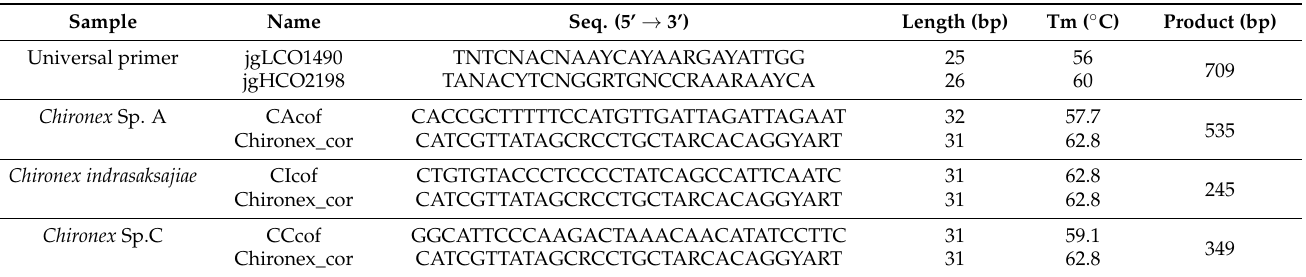
Table 4. List of the 16S rRNA primers of three Thai Chironex species.